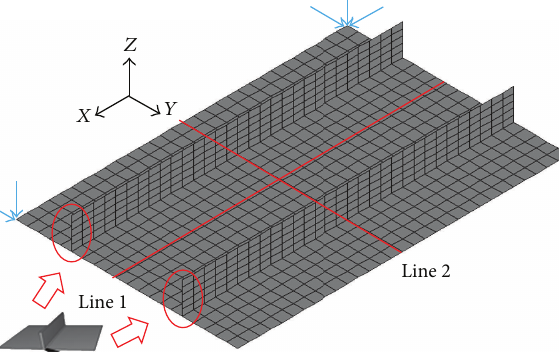
Figure 10: FEM model of the panel structure.